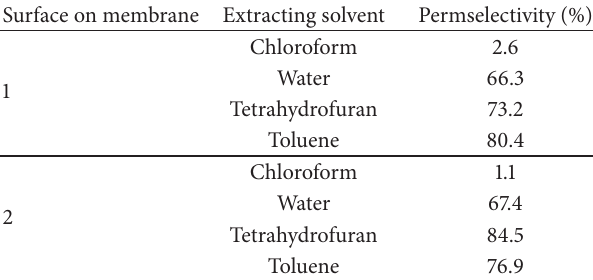
Table 5: Results of permselectivity for two-layer AEMs differing in surface layer type and extraction